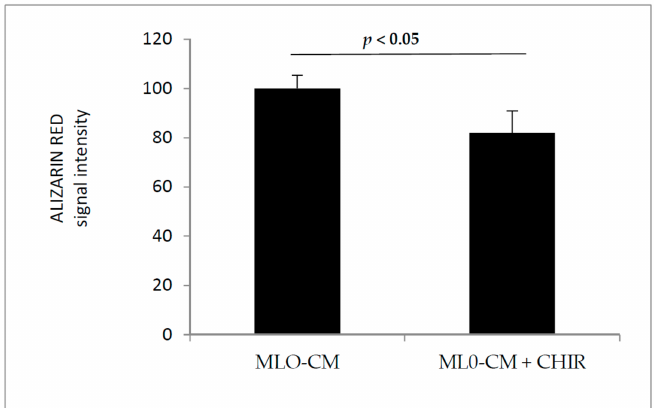
Figure 8. 2T3 osteoblast cells were maintained in differentiation medium for 5 days. The differentiating medium was added in a ratio of 1:4 with medium from MLO-Y4 that were previously treated with CHIR99021 at 100 nM for 48 h. At the end of the differentiation procedure, 2T3 were stained with Alizarin Red and the absorbance was read at 405 nM. The bars chart represents the normalized value of Alizarin Red signal intensity calculated from three independent